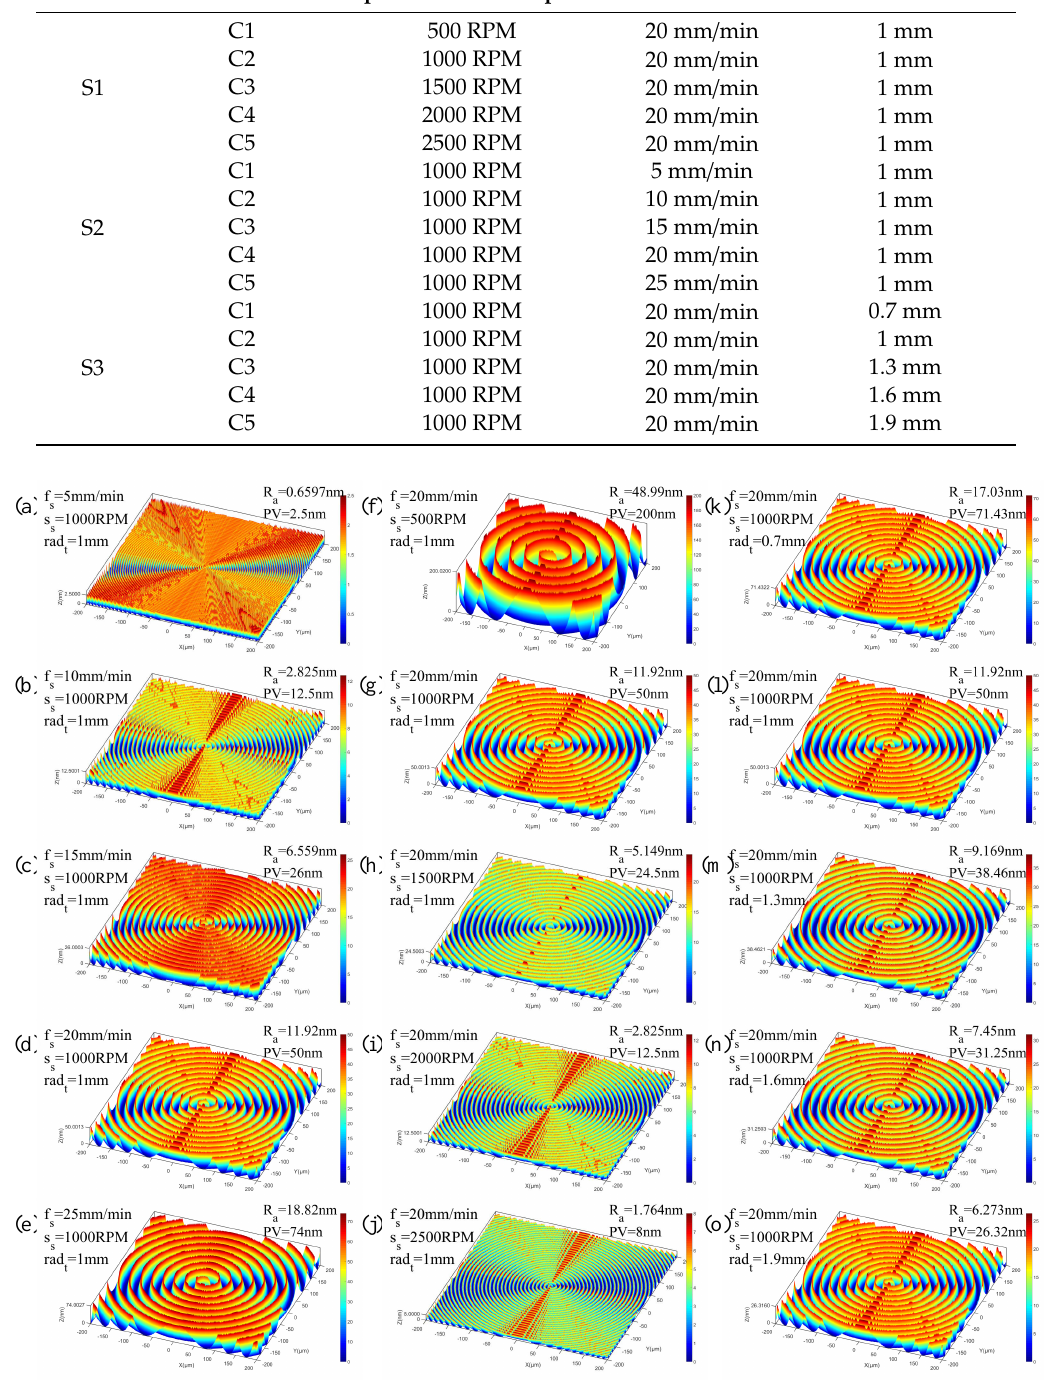
Figure 6. The simulated 3D surface topographies under different cutting parameters. Here, ( a – e ) are for the varying feed speed, ( f – j ) are for the varying spindle speed, and ( k – o ) are for the varying tool nose radius.